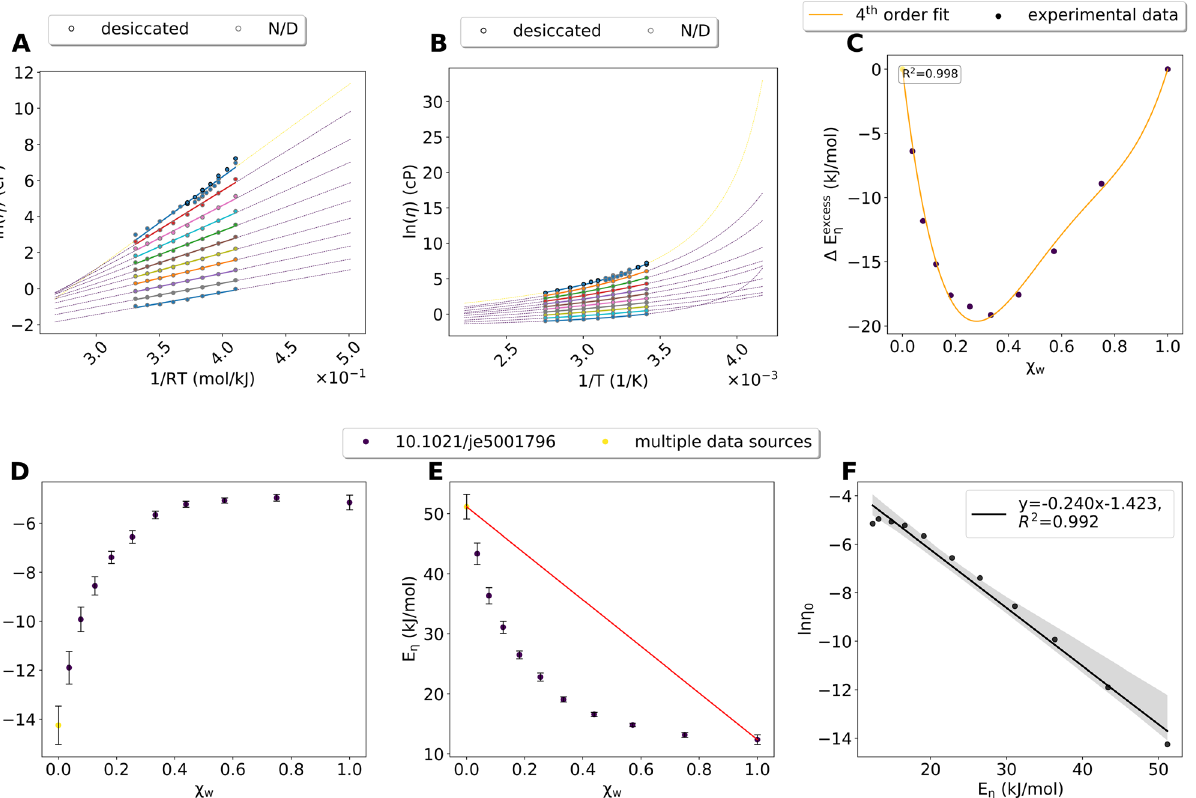
Figure 1. Reline–water mixtures. ( A ) Arrhenius fits (using a minimum of 3 data points). Dots and thick lines are the experimental data and the respective fit. The dashed lines are extensions of the fit. Colors of the dashed lines indicate the source of the data. Yellow: multiple data points from different sources were be combined. ( B ) excess VFT fits using a minimum of 4 data points. ( C ) E η calculated based on the red line in ( E ). Colors of the data points indicate the source of the data. ( D ) ln η 0 at different χ w . Error bars are calculated based on the fit in (A). Colors of the dashed lines indicate source of the data. ( E ) E η at different χ w . The red line indicates the behavior of excess an ideal binary mixture and was used to calculate E η . ( F ) Correlation between ln η 0 and E η